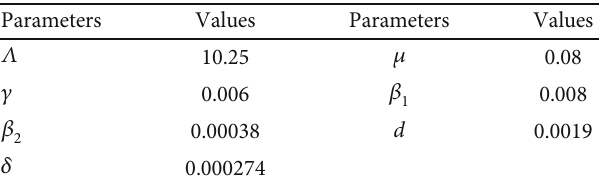
Table 3: Parameter values for verifying the global stability of smoking-free